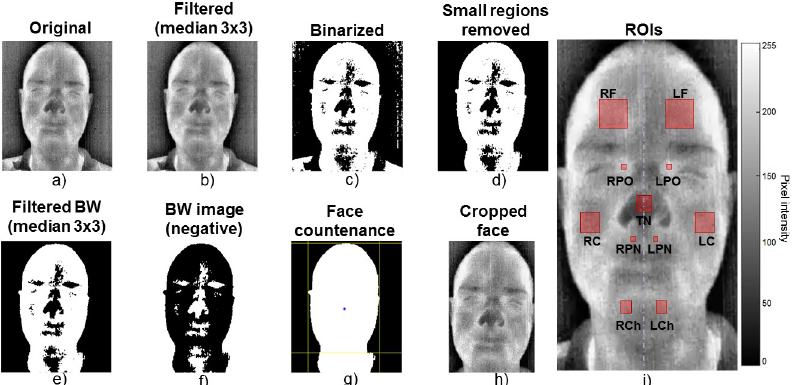
Fig 2. Representation of the pre-processing sequence of the facial thermal images and the eleven regions of interest (ROIs). i) ROIs: LF—forehead (left side); RF—forehead (right side); LPO—left periorbital region; RPO—right periorbital region; TN—tip of nose; LR—left cheek; RC—right cheek; LPN—left perinasal region; RPN—right perinasal region; LCh—chin (left side) and RCh—chin (right